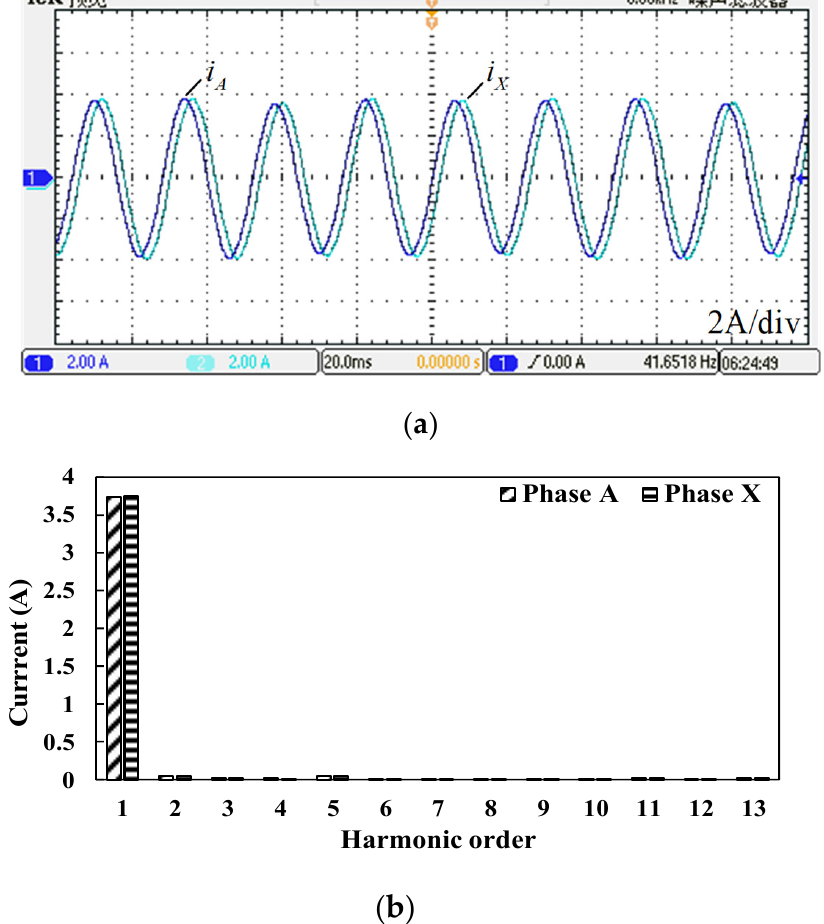
Figure 8. Experimental results with triple stationary control, ( a ) currents: Channel 1: phase of A, Channel 2: phase of X (2A/div), Horizontal: Time (0.02 s/div); ( b ) corresponding harmonics analysis. (PS: “预览” means preview, “噪声滤波器” means Noise Filter).